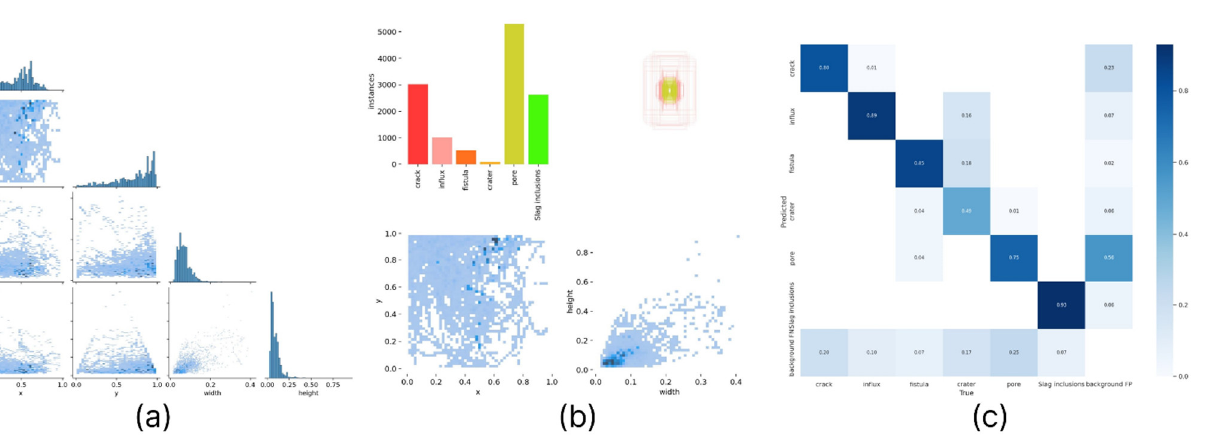
Figure 8. First case model training and validation metrics for a set of counter images. Additionally, for a qualitative result obtained from the examination, we collected pairwise graphs of the dependence of the quality metrics of the algorithm used, such as precision, recall, f1, and confidence (Figure 9).